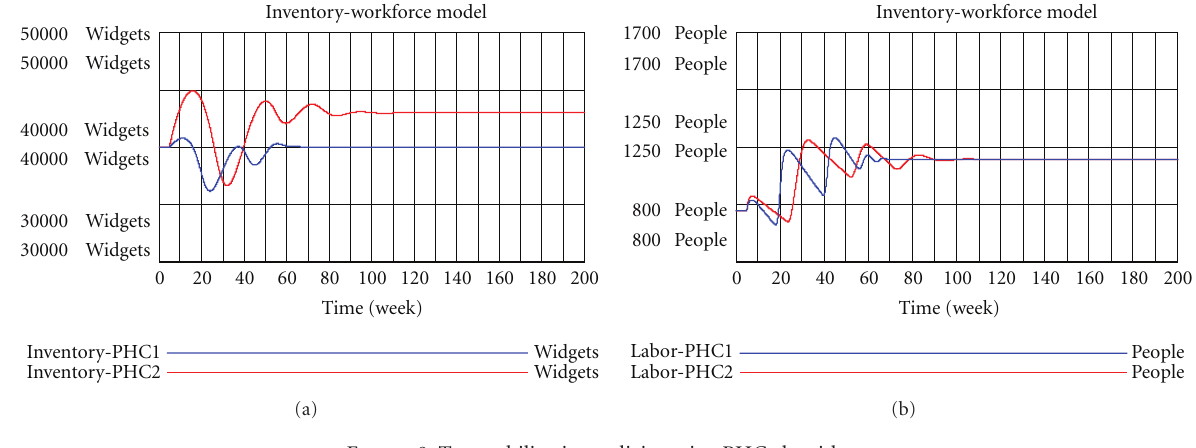
Figure 8: Two stabilization policies using PHC